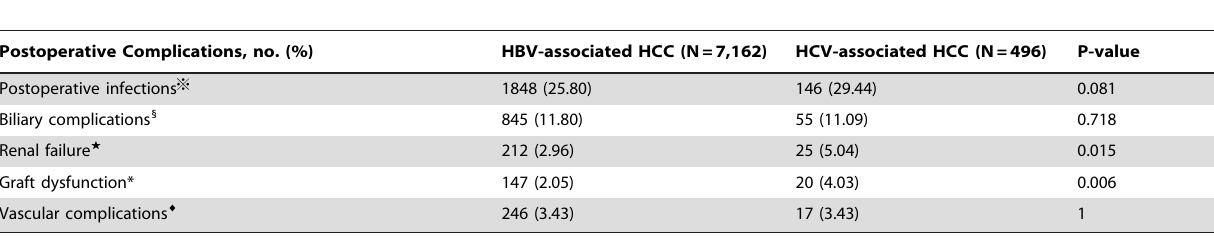
Table 2. Postoperative complications in patients with viral hepatitis-associated HCC who underwent liver transplantation.